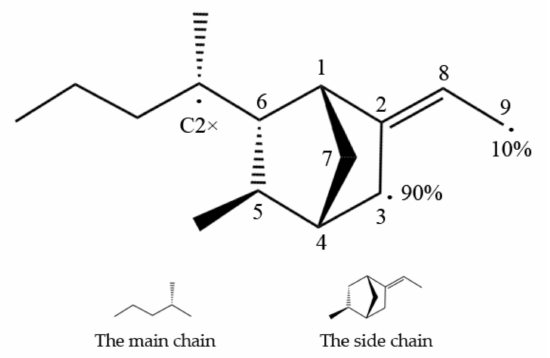
Figure 1. Possible EPDM reaction sites for the main chain and side chains (reprinted from [20]).